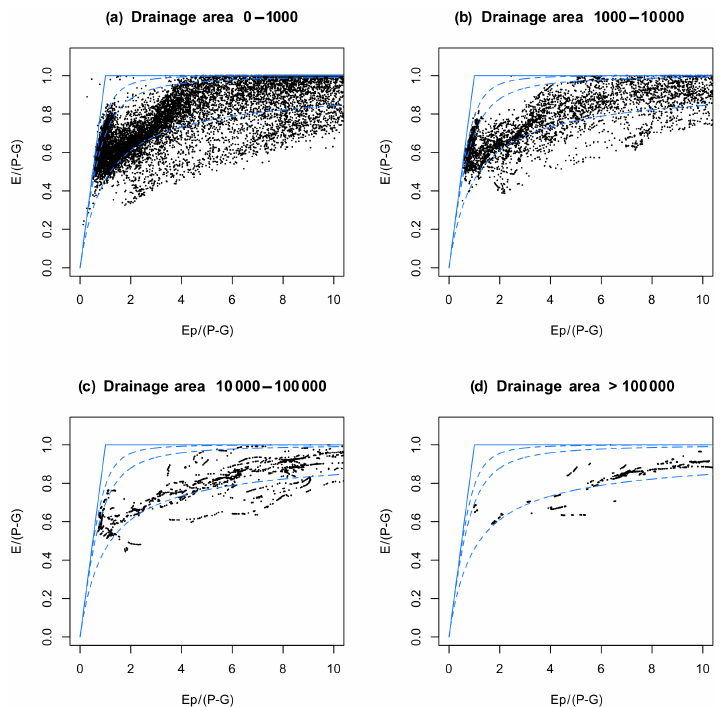
Figure 10. Budyko plots of evapotranspiration ratio versus aridity index using the effective precipitation method with watersheds grouped by drainage area [km 2 ]. Blue dashed lines are Budyko curves with shape parameters of 1.6, 2.6 and 3.6 (refer to Fig. 4) and the solid blue lines show the water and energy limits.